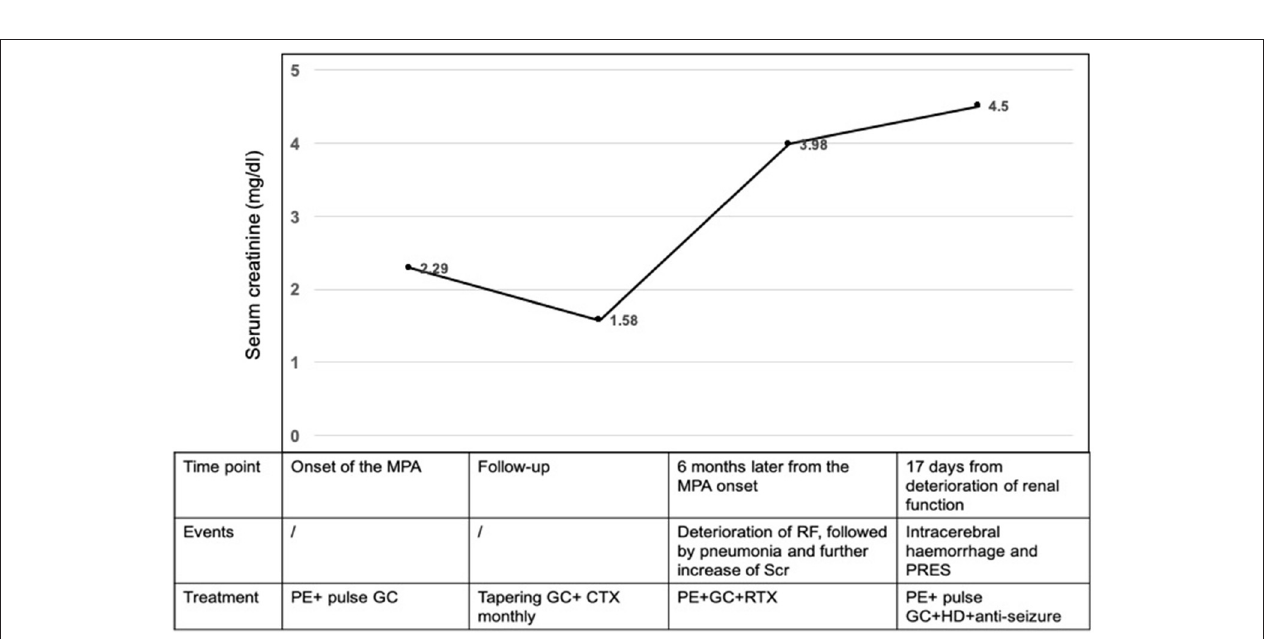
FIGURE 2 | Magnetic resonance imaging (MRI) of brain. T2-weighted (A-1) and FLAIR (A-2) sequences depict hyper-intense lesions involving the bilateral cerebral hemispheres (occipital lobe, parietal lobe, temporal lobe and frontal lobe) and cerebral cortex and subcortex (arrows), most of which disappeared 17 days later (B-1,B-2) . Diffusion-weighted magnetic resonance imaging (A-3) and apparent diffusion coefficient (A-4) sequences of the involved regions showed isointense or hyperintensity lesions (arrows).